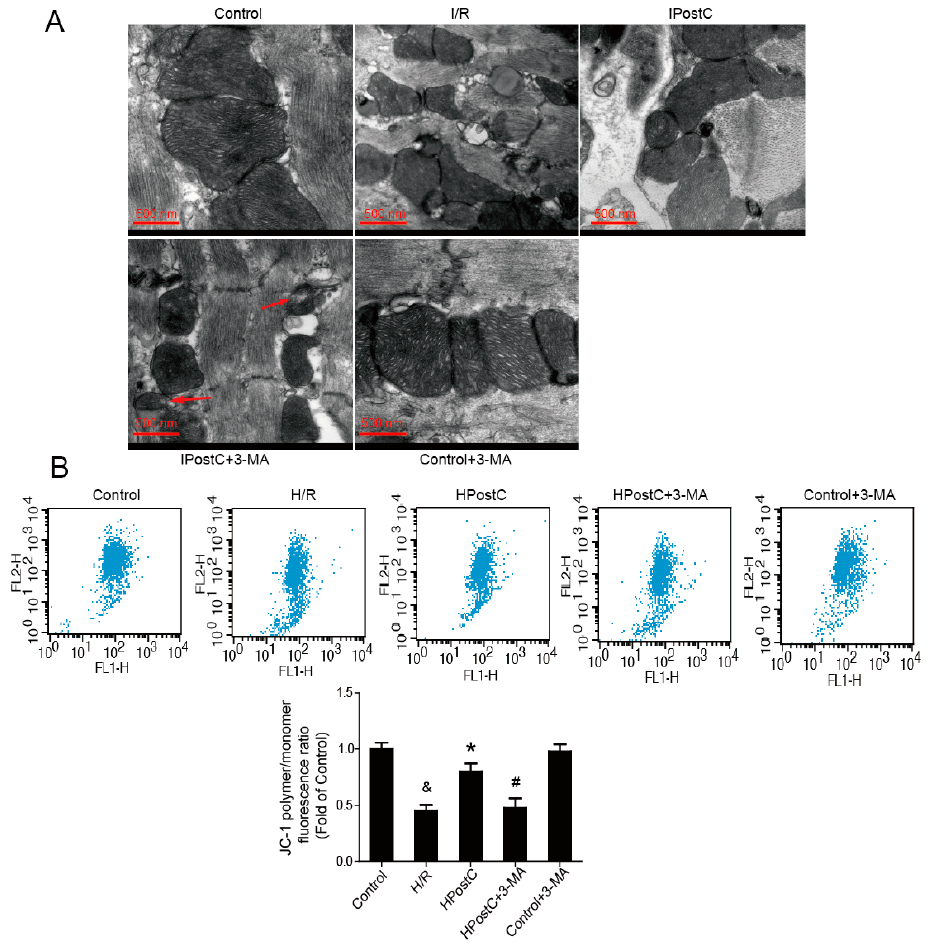
Figure 7. Determination of mitochondrial function. ( A ) Mitochondrial morphology was observed under electron microscopy in the myocardium (mitochondrial vacuoles were indicated by red arrows); ( B ) Measurement of mitochondria membrane potential after 30 min of reoxygenation. & p < 0.05 versus control, * p < 0.05 versus H/R, # p < 0.05 versus HPostC. The mean values ± SEM, n = 6.